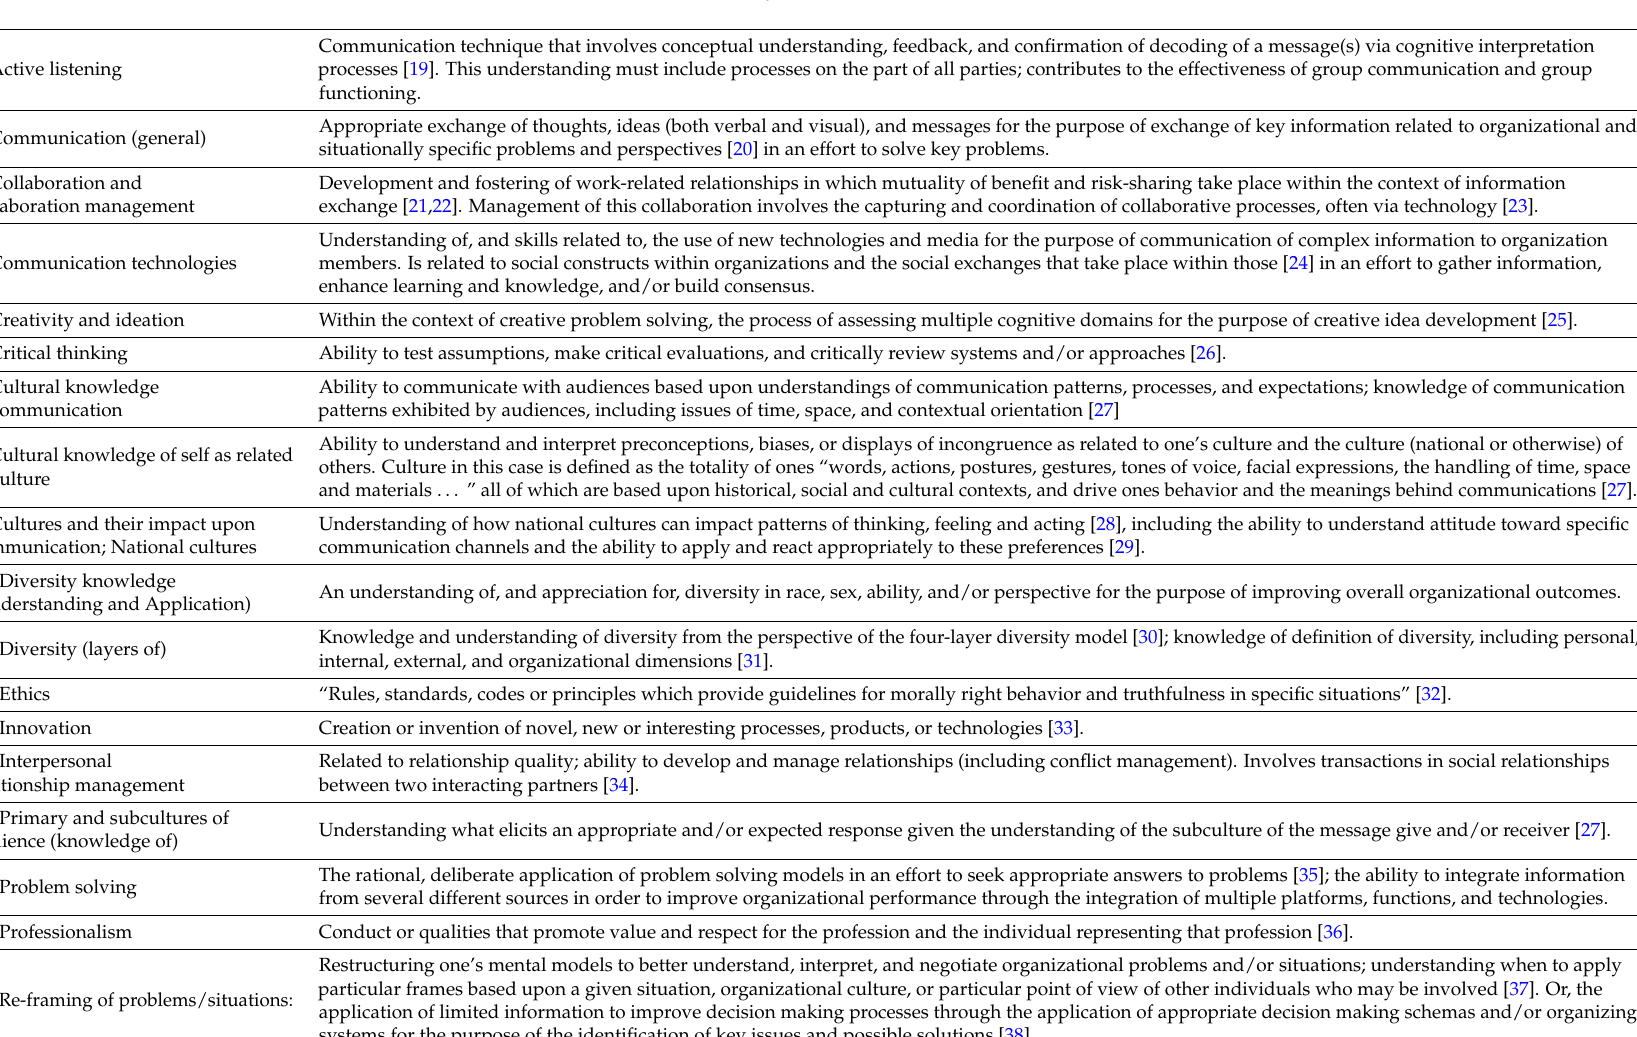
Table 1. Taxonomy of Non-Technical